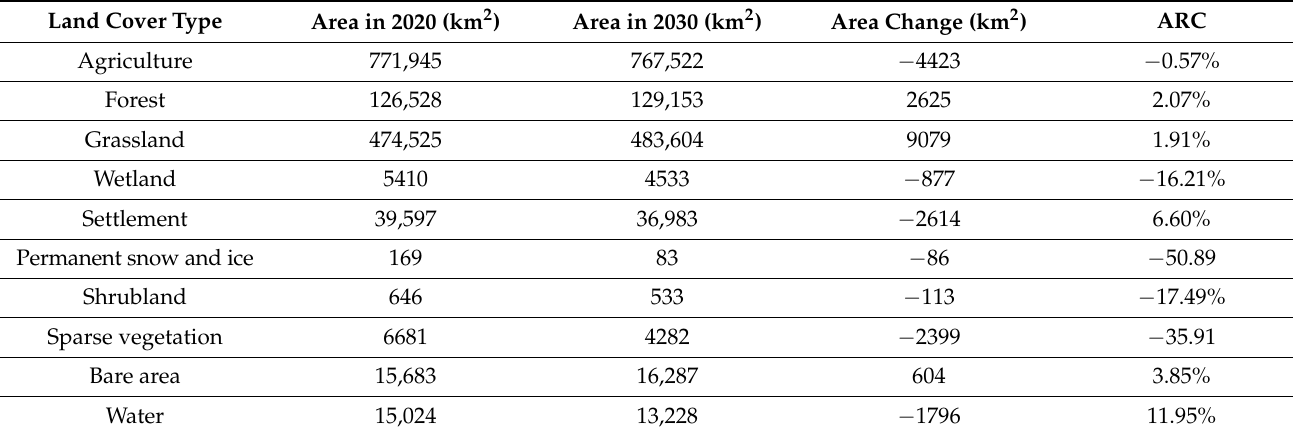
Table 4. Land cover change from 2020 to expected 2030.